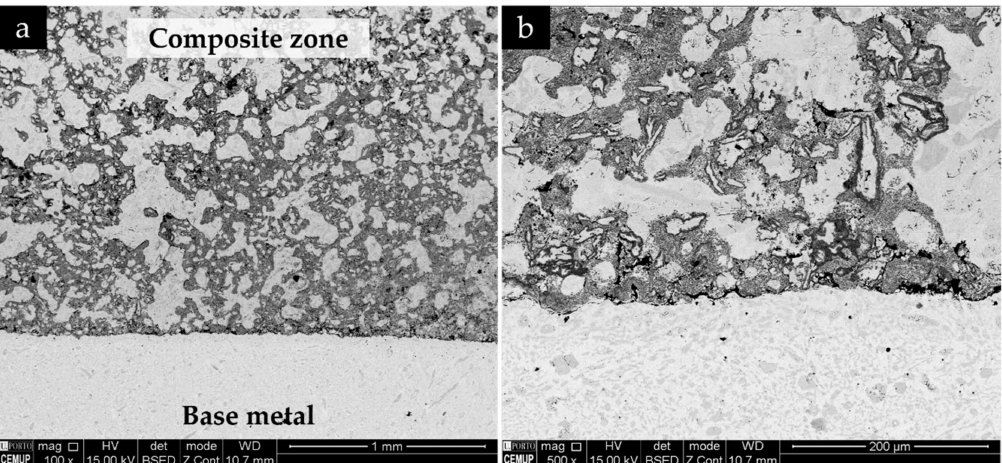
Figure 11. SEM-BSE images of the microstructure of the reinforced specimen: ( a ) base metal and composite and ( b ) interface region at higher magnification.